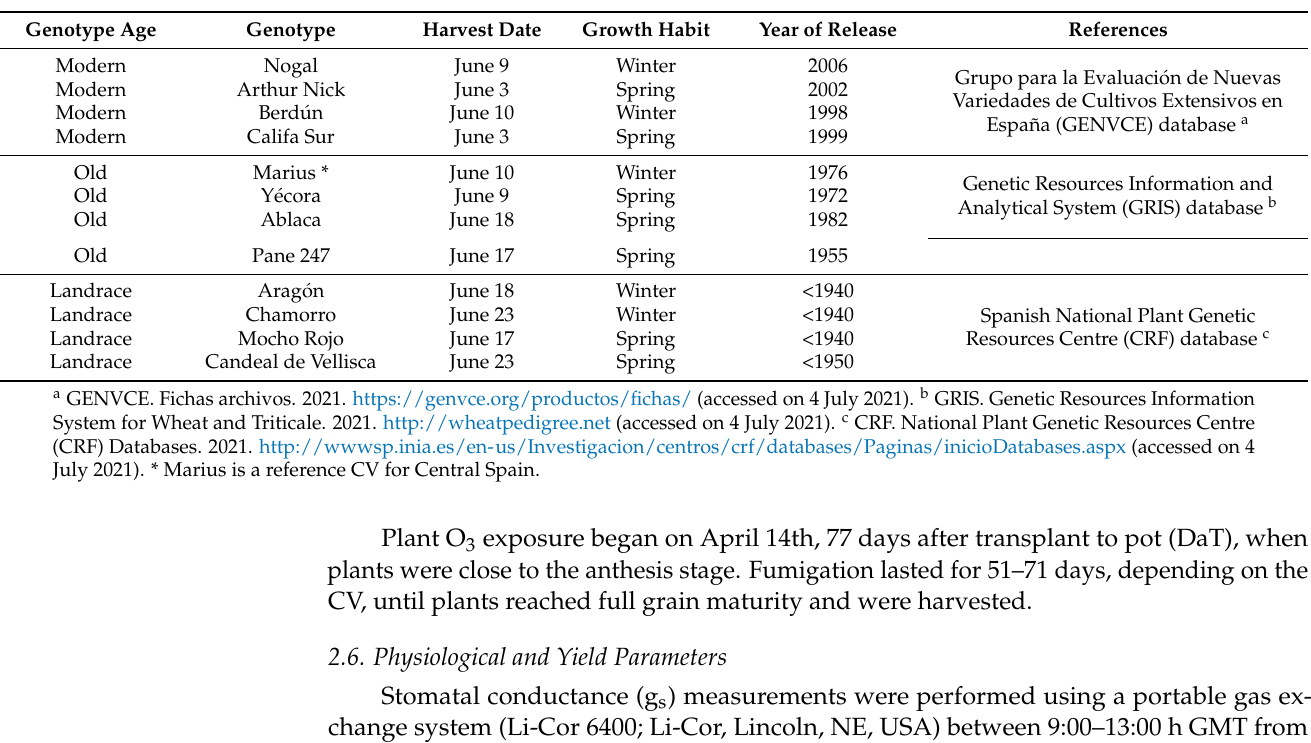
Table 1. Wheat genotype grown under Mediterranean conditions, Genotype Age, Harvest Date, Growth Habit, Year of Release and References. The dashed line represents pre and post green revolution release